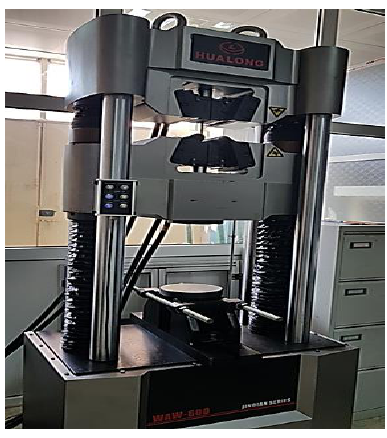
Figure 5: Tensile test machine Table 4: The tensile test results of the cylinders and unformed plate (base metal)